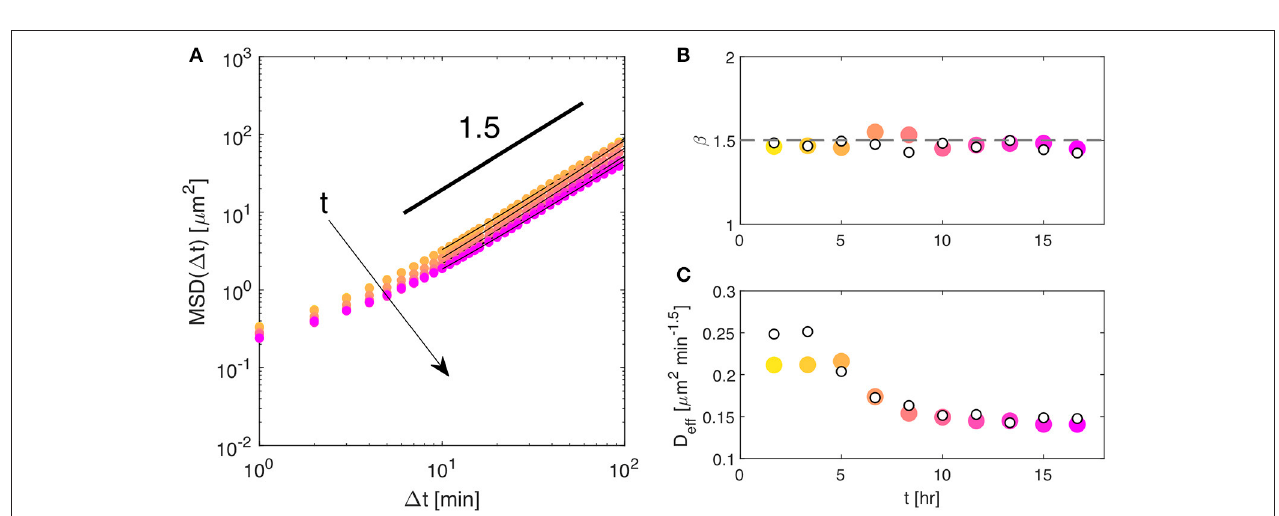
FIGURE 4 | (A) Symbols: mean squared displacement MSD obtained from DDM analyisis (phase contrast imaging), performed over a time window of 200 min, at different time points over the course of the experiment. Continuous lines are best fitting curves to the date with the model given in Equation (13). (B) Temporal evolution of the exponent β describing the long-time scaling of the MSD (see Equation13). Empty symbols are obtained from PT, filled symbols from DDM. (C) Temporal evolution of the prefactor D eff of the power-law describing the asymptotic behavior of the MSD (see Equation 13) . Empty symbols are from PT, filled symbols from